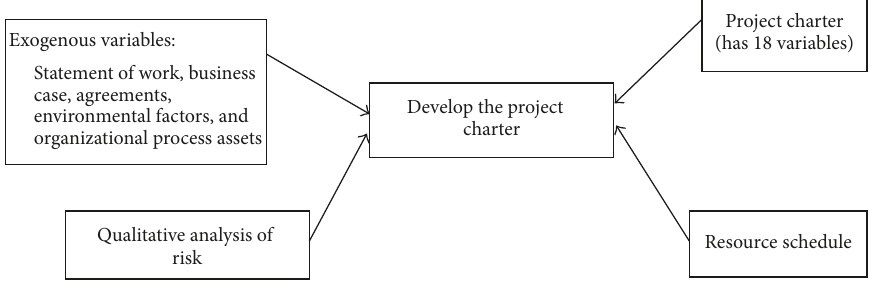
Figure 1: Area of knowledge of integration, initiation process, and development of the project charter subprocess (based on PMBOK).